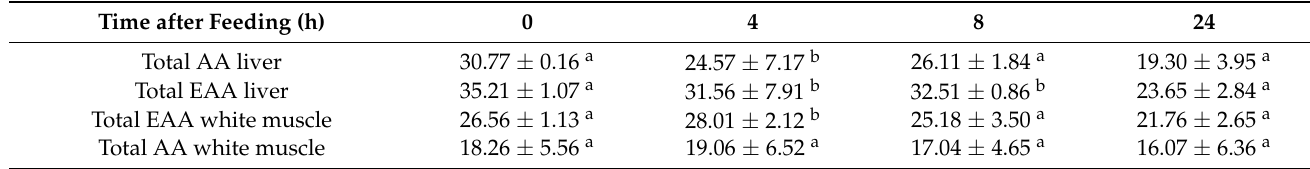
Table 2. Free total (AA) and total essential amino acids (EAA) (mg/100 g wet tissue) in liver and white muscle for sea bream before feeding (0 h) and at different times after feeding (4, 8, 24 h) (mean ± SE, n = 9 at each time). Time after Feeding (h)